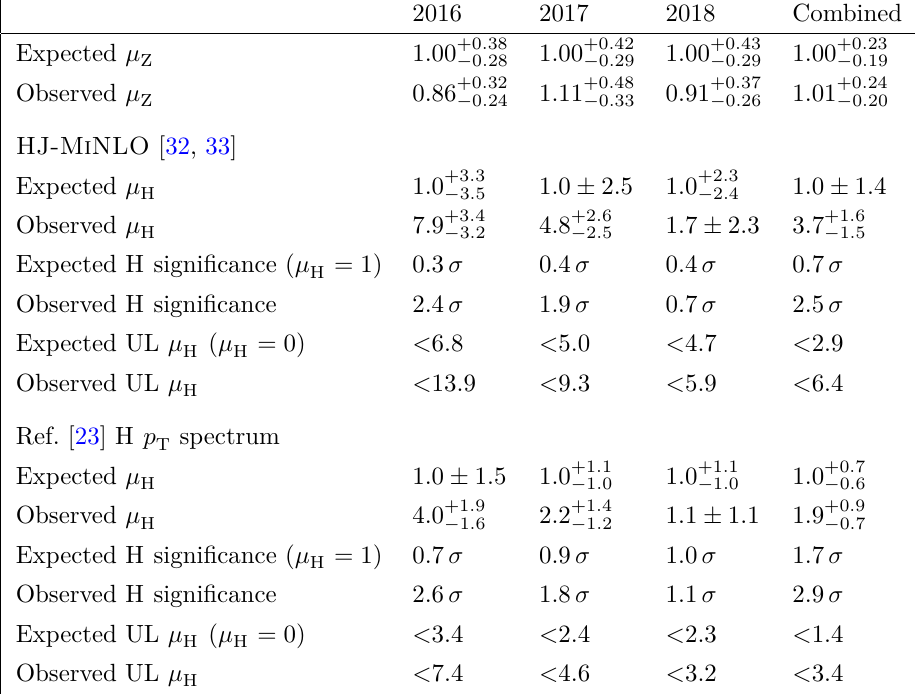
Table 3 . Fitted signal strength, and expected and observed significance of the Higgs and Z boson signals. The Higgs boson results are presented with two ggH signal models, one using the nominal HJ-MiNLO sample and the other simulated with the same procedure described in ref. [23]. The 95% confidence level upper limit (UL) on the Higgs boson signal strength is also listed. In the results for the Higgs boson, the Z boson yield is fixed to the SM prediction value with the corresponding theoretical uncertainties to better constrain the data-to-simulation scale factor for the DDBT. For the expected and observed signal strengths of the Z boson, the Higgs boson signal strength is freely